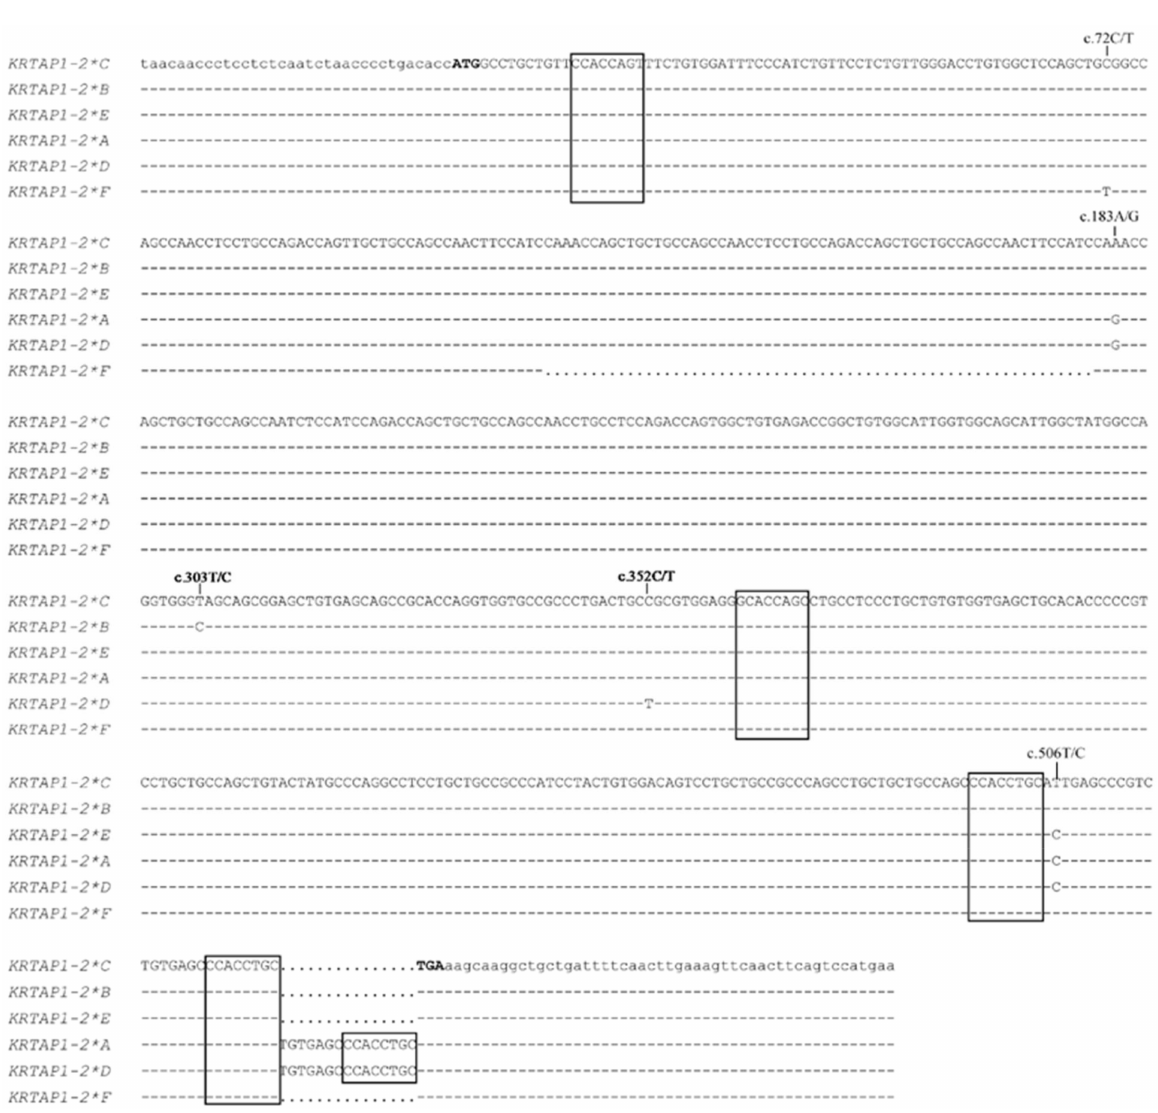
Figure 2. Nucleotide sequence alignment of the caprine KRTAP1-2 sequences. The dashes indicate the same nucleotide with respect to the sequence of caprine KRTAP1-2*C and the dots represent nucleotide deletions. The single nucleotide polymorphisms identified among these sequences are indicated above the sequences. The notional ATG (start codon) and TGA (stop codon) are shown in bold, and the Chi-like sequences are shown in box. The uppercase letters indicate nucleotides in the coding region, whereas the lowercase letters indicate nucleotides in the non-coding region. The numbering of nucleotides and amino acid positions follows the Human Genome Variation Society (HGVS) nomenclature (http://varnomen.hgvs.org/; accessed on 15 November